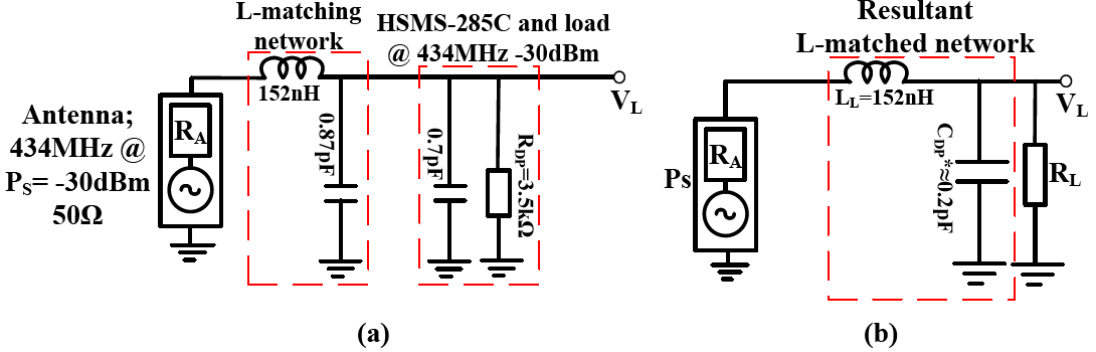
Figure 6. ( a ) L-matched impedance circuit for matching the HSMS-285C diodes at 434 MHz for −30 dBm input. ( b ) Resultant network, ( c ) PCB layout of the L-matched Delon doubler with adjusted values on FR4 substrate ( d ) Fabricated PCB of the L-network matched Delon voltage